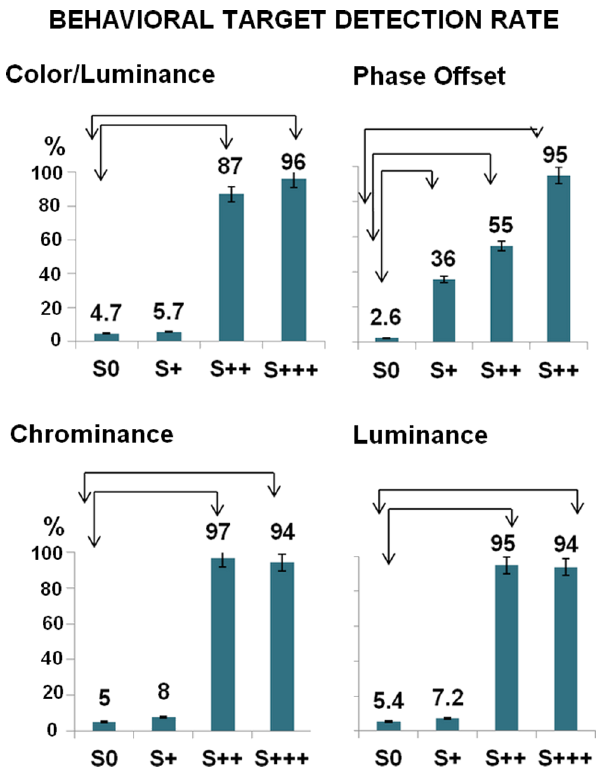
Figure 2. Participant’s behavioral Target detection rates (all 4 experiments) and classification of behavioral subliminal vs. supraliminal levels. Note that S + (saliency level 1) is not separable from S0 (standard reference) from the visual awareness point of view, and can therefore be classified as a subliminal condition, except for the phase offset experiment. Accordingly, no differences were found between both S0 and S + target detection proportions (binomial distribution test) except for the latter condition. In other words S + did not elicit responses beyond the guessing the rate (which was very low and similar to the probability of the rare target occurrence). Arrow intervals depict comparisons between S0 and all other conditions (significant at the 0.05 level). Bars depict confidence intervals for the sample means at 95%.